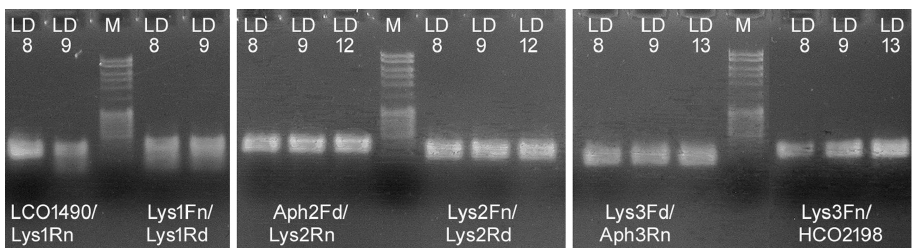
Figure 6. Agarose gel visualizing the products of nested trials with products of direct PCR for samples LD8 – L. confusus , LD9 – L. desertorum ; LD12 – L. fabarum ; and LD13 – L. alpinus . The products of LD8 and LD9 from PCR with LCO1490/Lys1Rd were submitted to secondary reactions combining two primer pairs, viz., 1. LCO1490/Lys1Rn; and 2. Lys1Fn/Lys1Rd. Amplicons of LD8, LD9 and LD12 ob- tained with Aph2Fd/Lys2Rd were submitted to secondary nested trials with primer pairs Aph2Fd/Lys2Rn and Lys2Fn/Lys2Rd. Products from direct PCR with Lys3Fd/HCO2198 were used as the template for nested reactions with Lys3Fd/Aph3Rn and